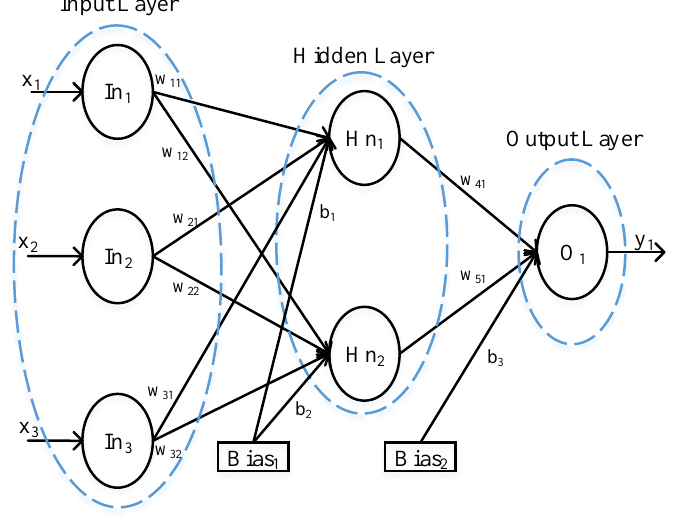
Figure 2. Candidate solutions of 3-2-1 FNN